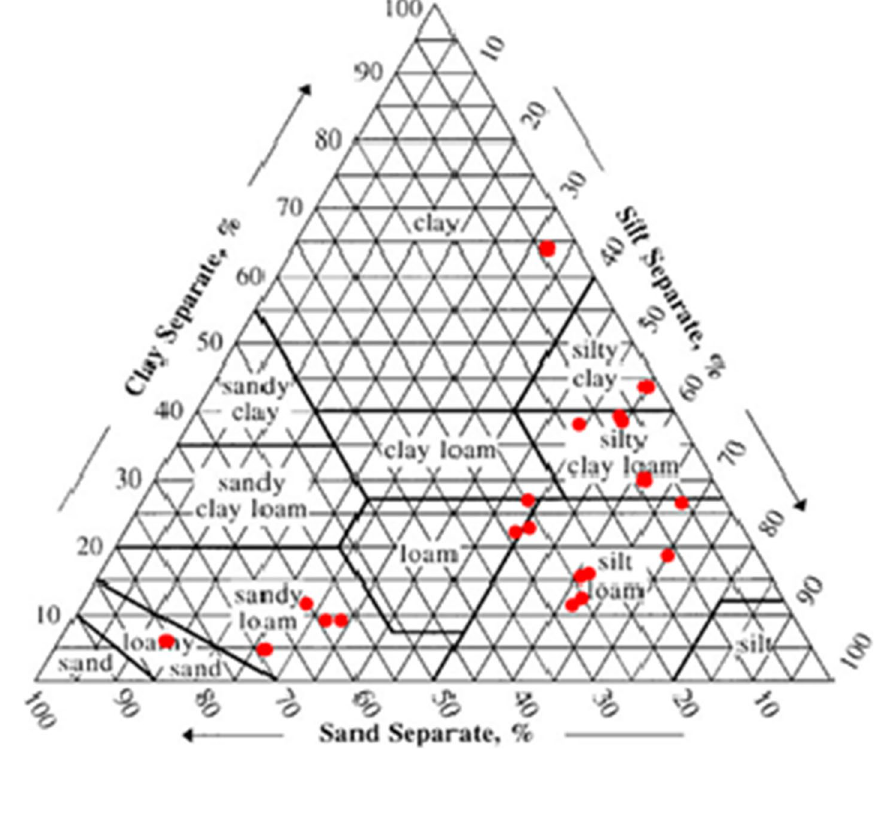
Soil no. Sand (%) Silt (%) Clay (%) Texture Hyd. hydrological soil groups (HSG) for the soil sites in the study area